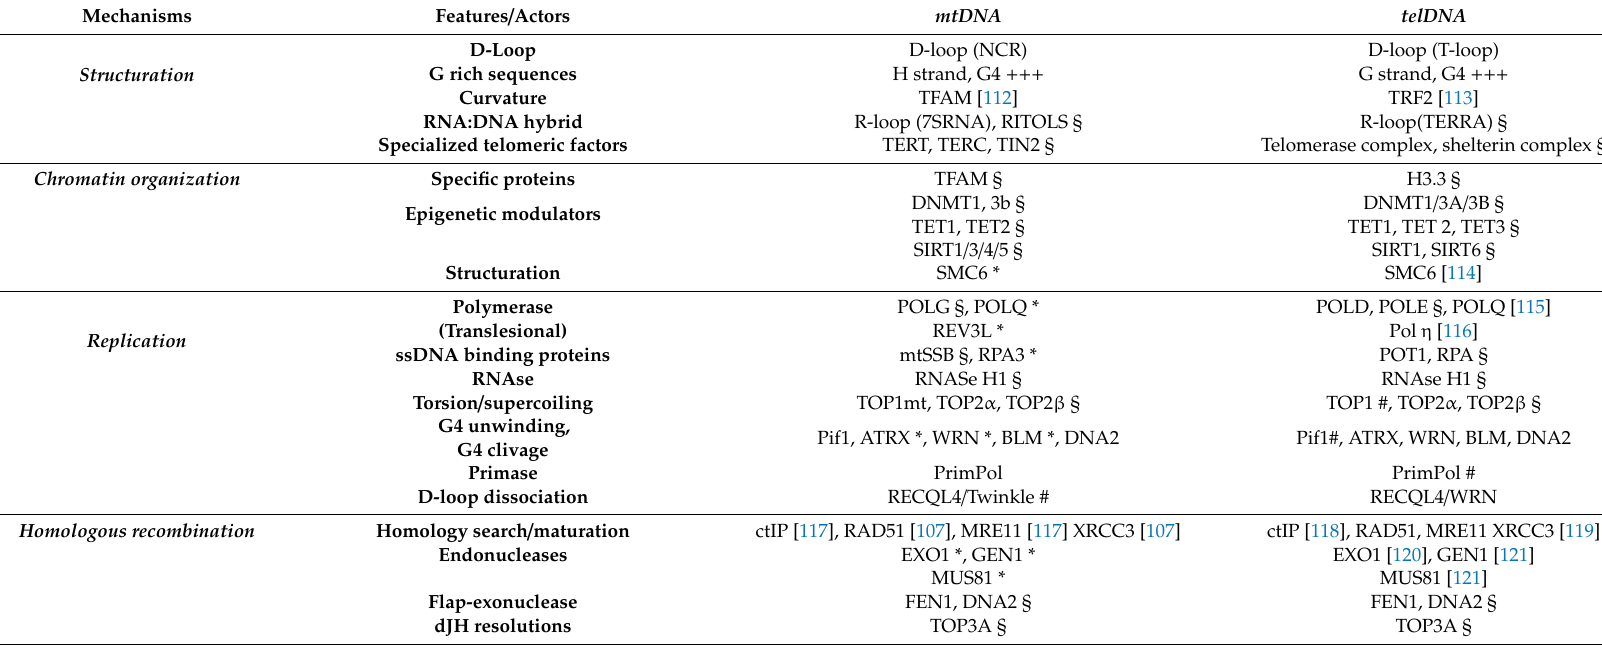
Table 1. Listing of the common or equivalent proteins influencing replication at both telomere (telDNA) and mitochondrial DNA (mtDNA) (in